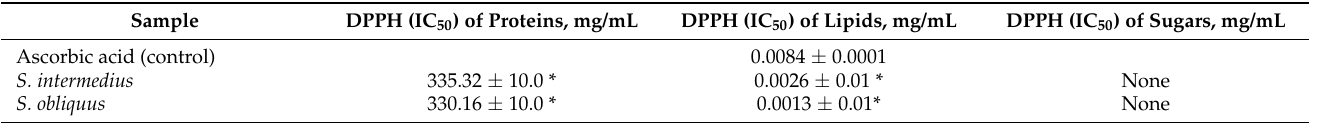
Table 3. Indicators of antioxidant activity of S. intermedius and S. obliquus (Filinskaya Bay, Baltic Sea) extract samples.